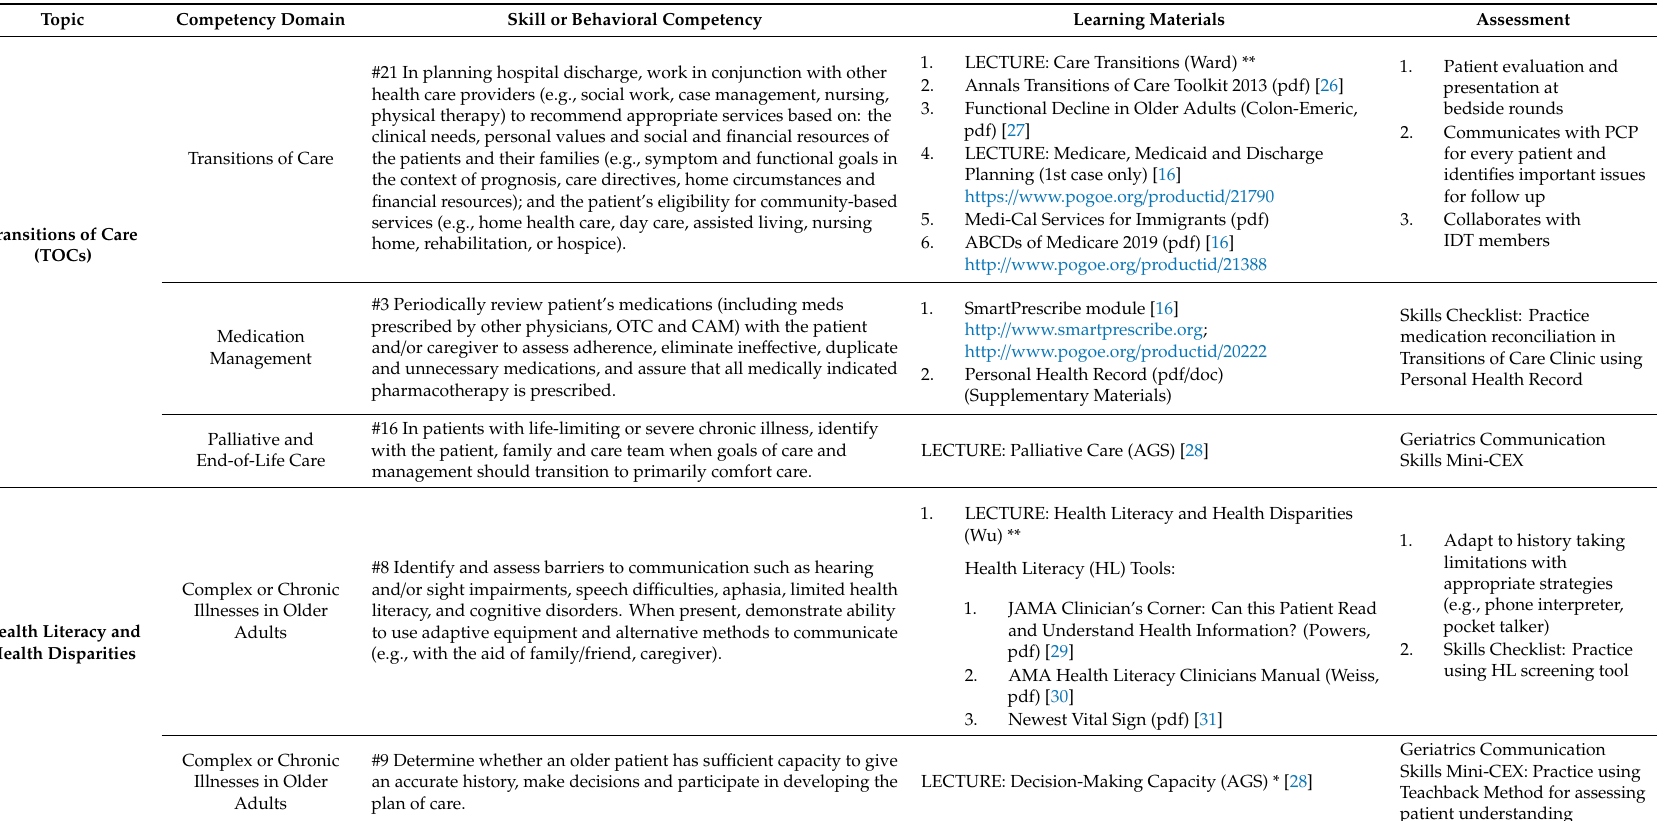
Table A1. IM Resident Geriatrics Competencies and Didactic